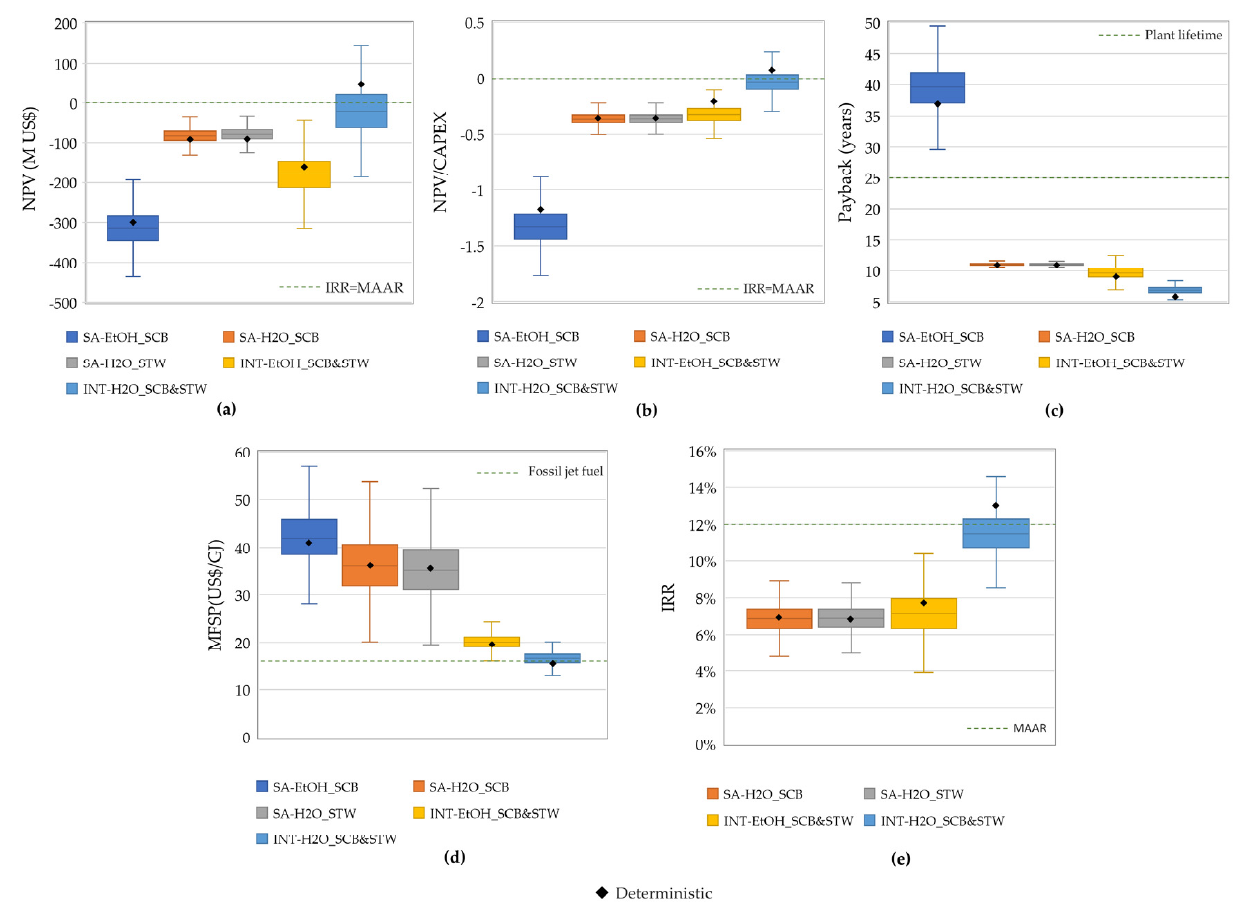
Figure 3. Results from the discounted cash flow analysis based on the Monte Carlo analysis: ( a ) NPV (MUSD/year), ( b ) NPV/FCI, ( c ) payback (years), ( d ) SAF MFSP (USD/GJ), and ( e ) IRR